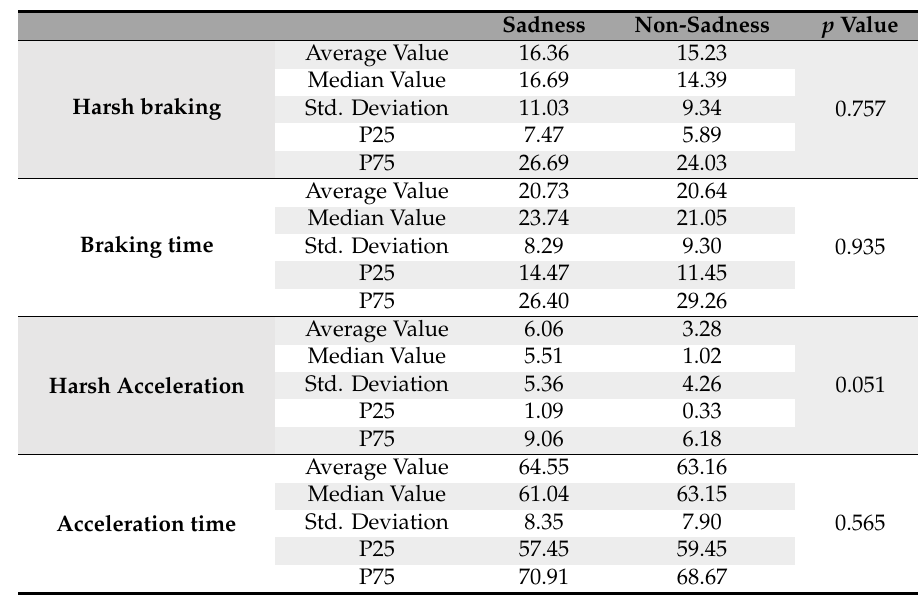
Table 9. Driving behavior grouped by sadness